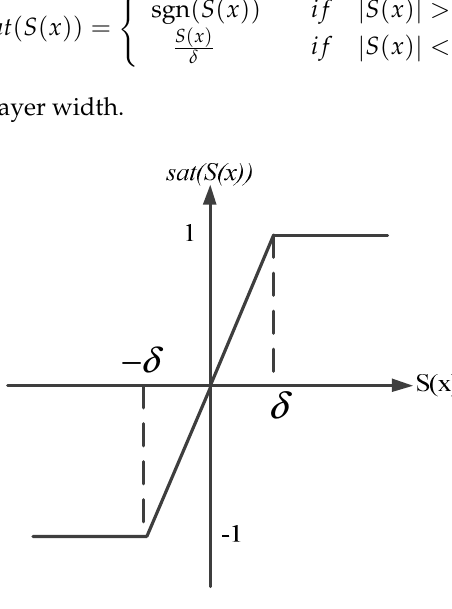
Figure 3. Saturation function.